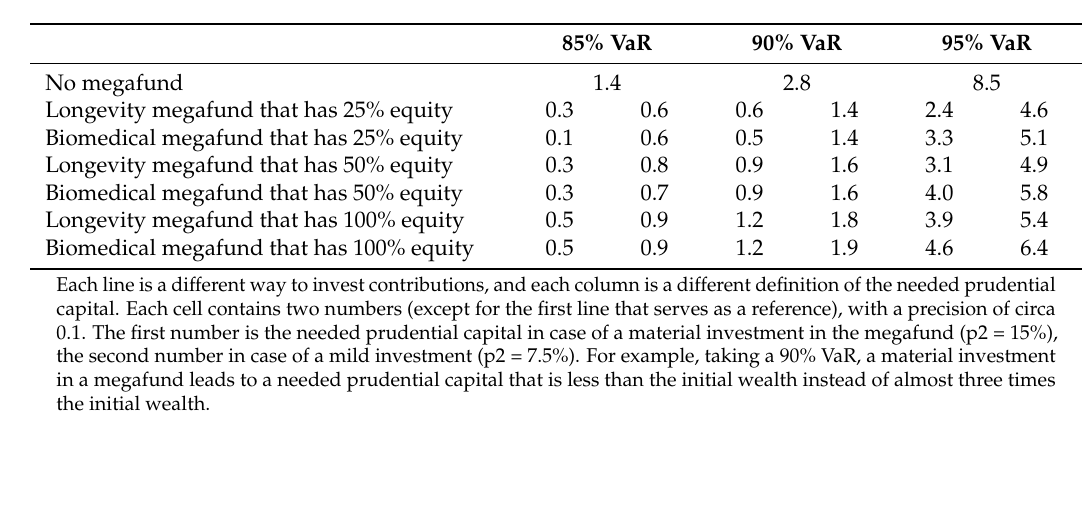
Table 2. Needed prudential capital, expressed as a proportion of the initial wealth, depending on investments in a longevity